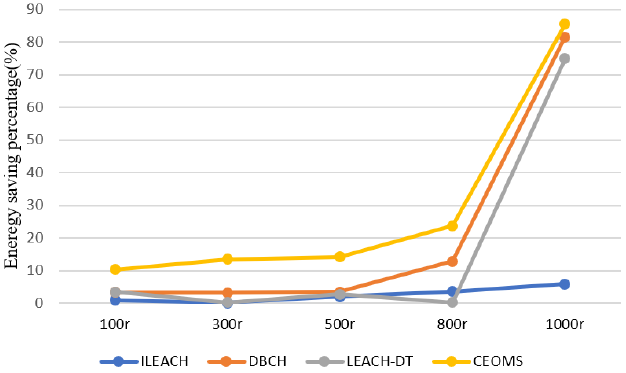
Figure 15. Energy saving percentage of four algorithms. It can be found that the curve corresponding to the CEOMS algorithm was higher than other three curves. It also demonstrates that the CEOMS algorithm had superior in energy